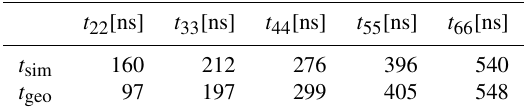
Table 3. Different attaching points for geometric model used in Eq. (4): y E , geo gained from main radii of array electrodes; y E , corr adapted points so that time differences (see Table 3) from geometric model and from sound field simulations